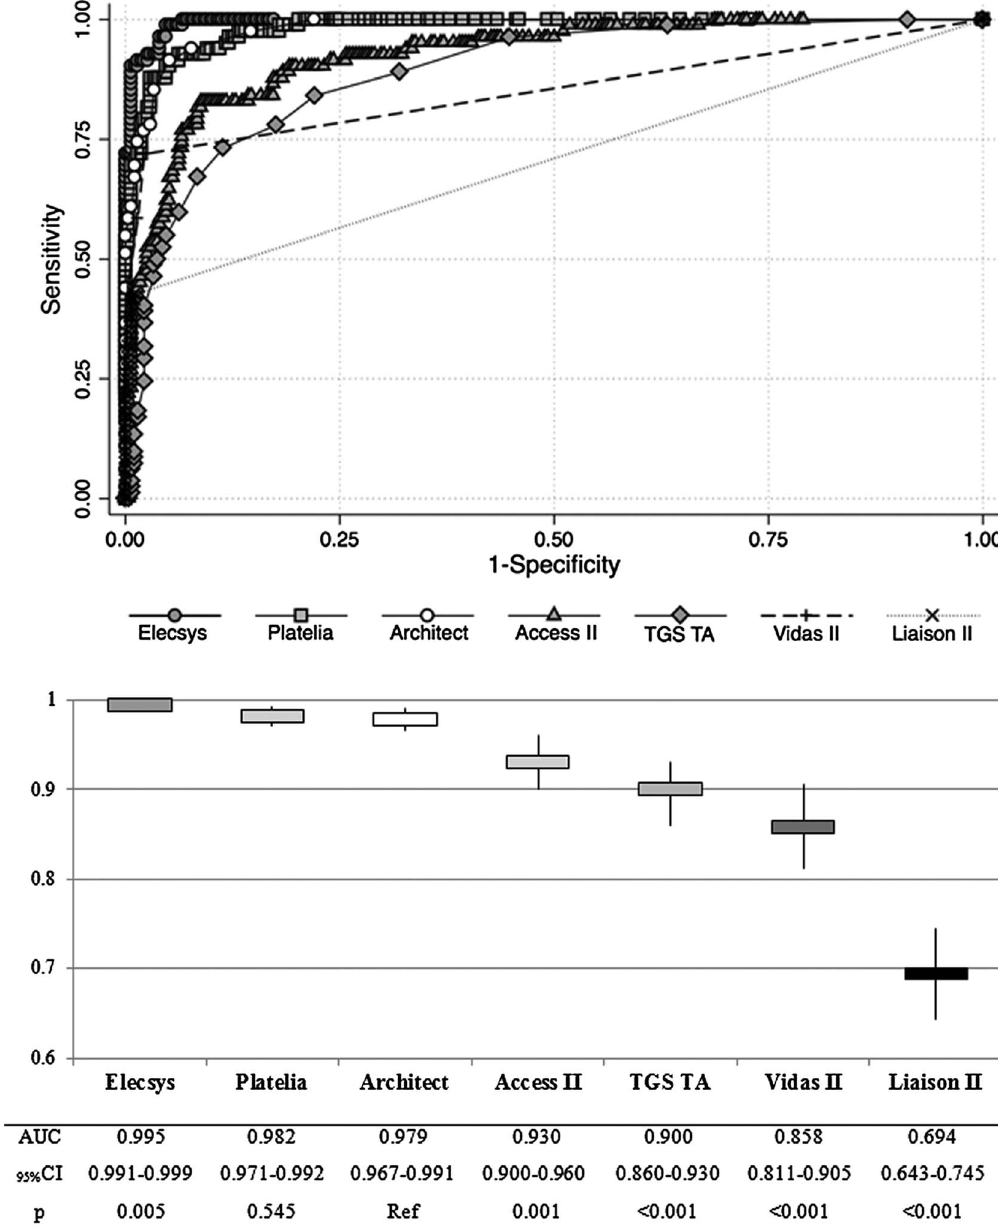
Figure 2. Areas under Receiving Operator Curves for each tested assay and comparison ( v 2 test) of analytic